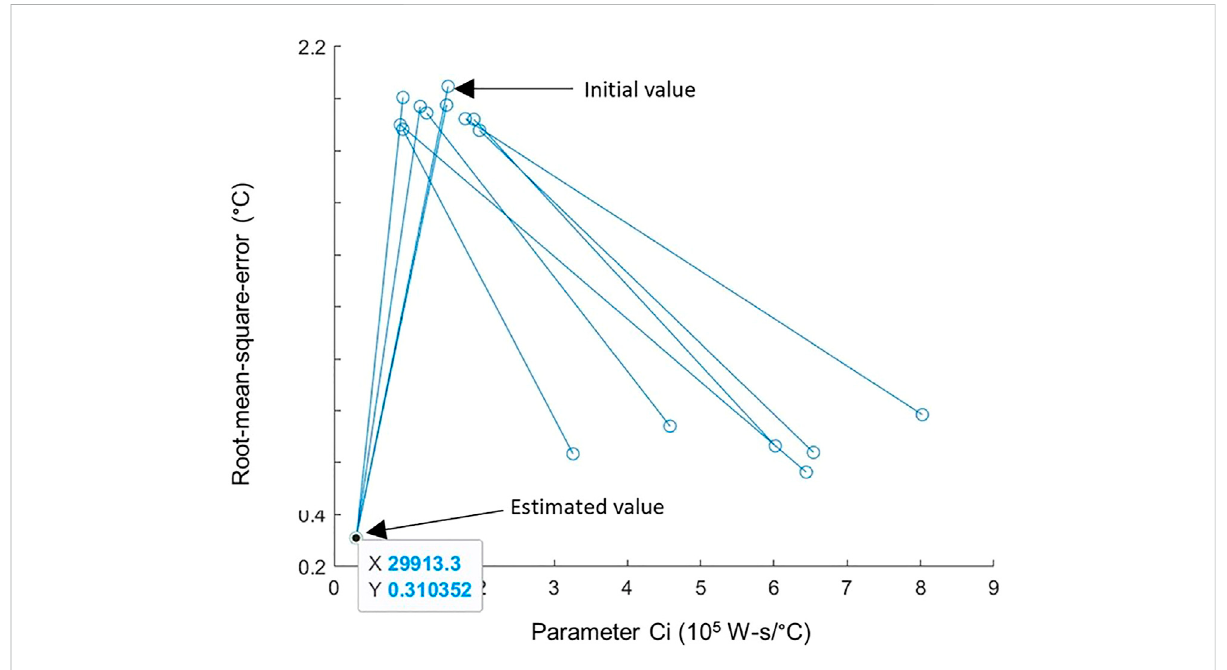
FIGURE 5 Initial vs. estimated values of parameter Ci when training with D5 in network